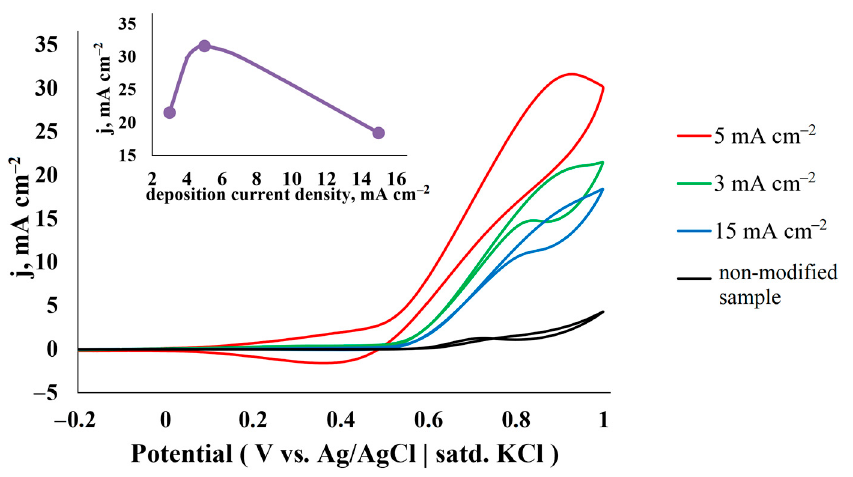
Figure 6. SEM images of the synthesized copper particles obtained for 7.5 min at a current density of − 3 A m − 2 ( a ), − 5 A m − 2 ( b ), − 15 A m − 2 ( c ).